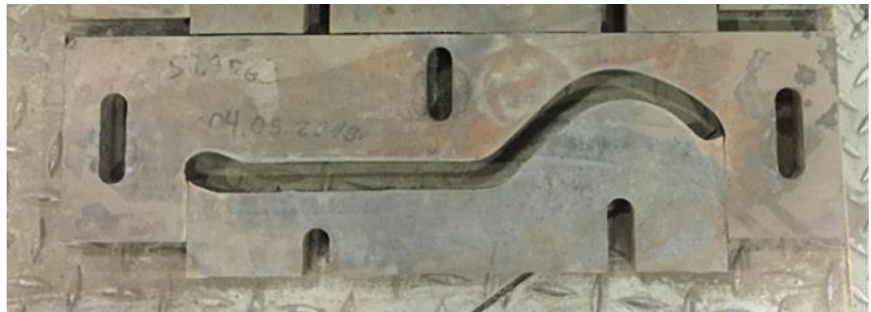
Figure 1. Tool forming a clay strand (bit) divided into the upper and lower element.